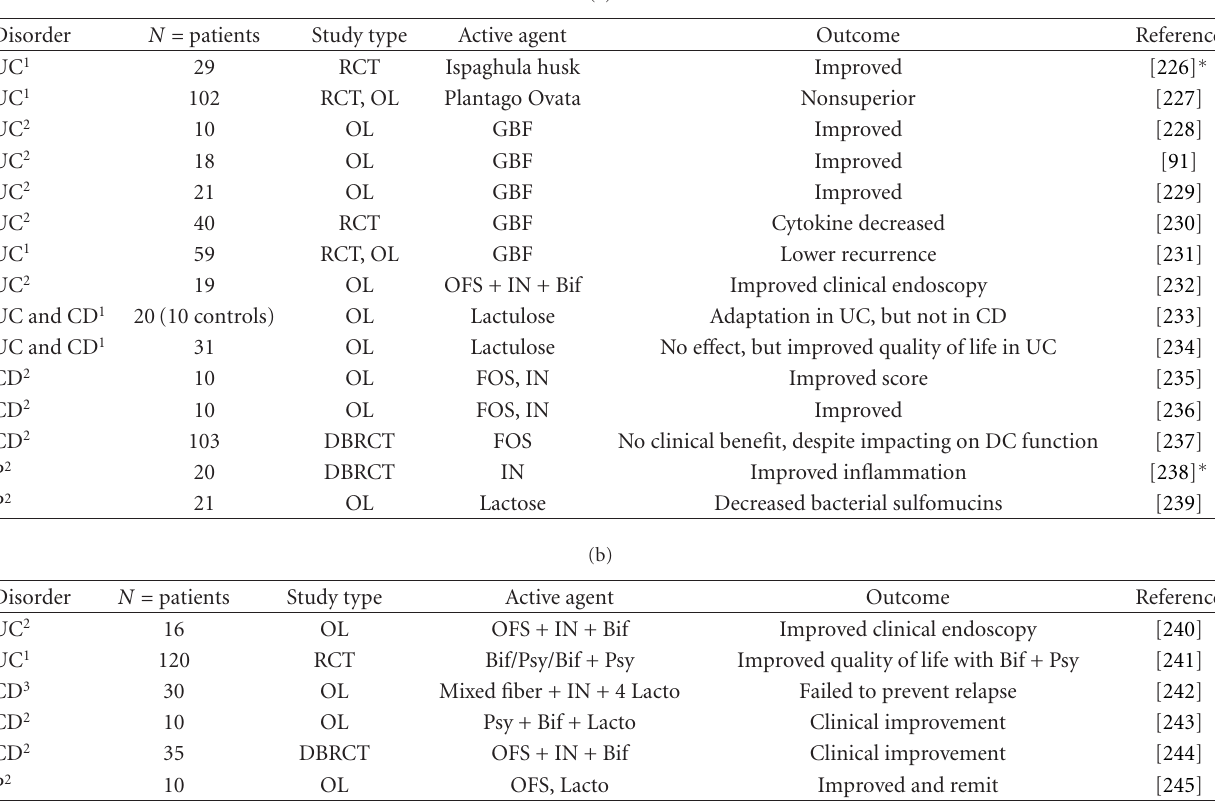
Table 4: (a) Human studies published on the use of prebiotics or nondigestible carbohydrates for inflammatory disorders. IBD: inflamma- tory bowel disease, UC: ulcerative colitis, CD: Crohn’s disease, and P: postoperative ileoanal anastomotic pouch inflammation, represents a spectrum of IBD recurrences. (b) Studies using combination of prebiotics and probiotics (synbiotics) for